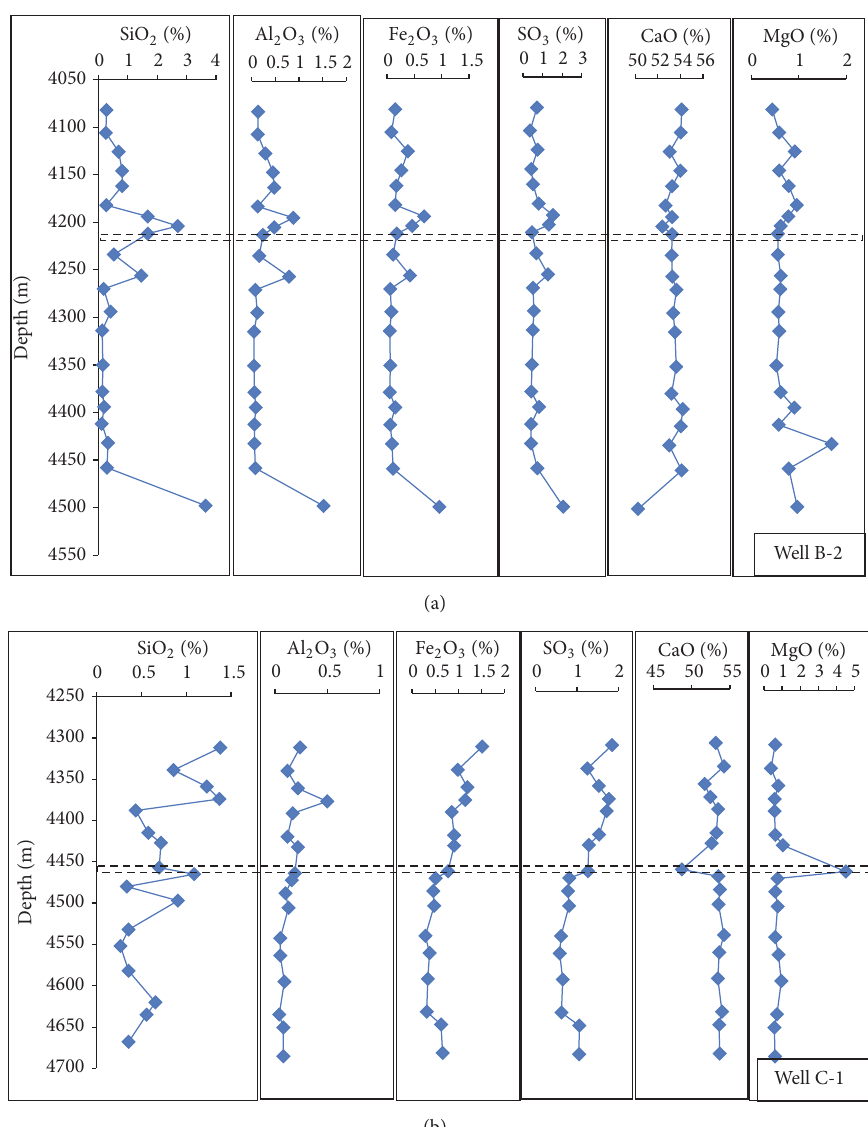
Figure 12: Chemical variation plots of selected major oxides showing depositional changes in the Lower Fahliyan Formation: (a) in well B-2 and (b) in well C-1 in different oil fields. Dashed lines are correlated to a differentiated horizon of two formation pore pressure systems (high and